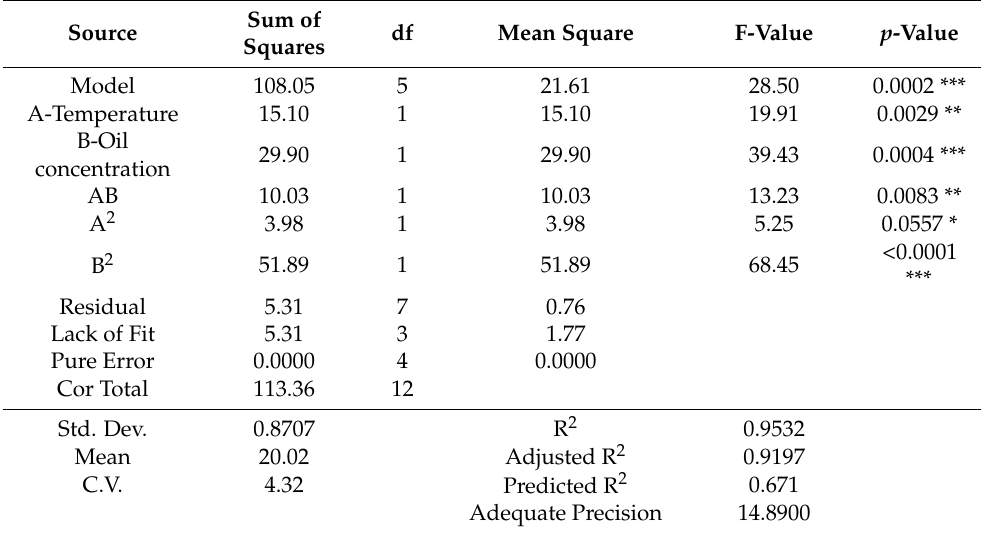
Table 6. Analysis of variance (ANOVA) of the central composite design (CCD) model used to identify the factor significantly influencing oil